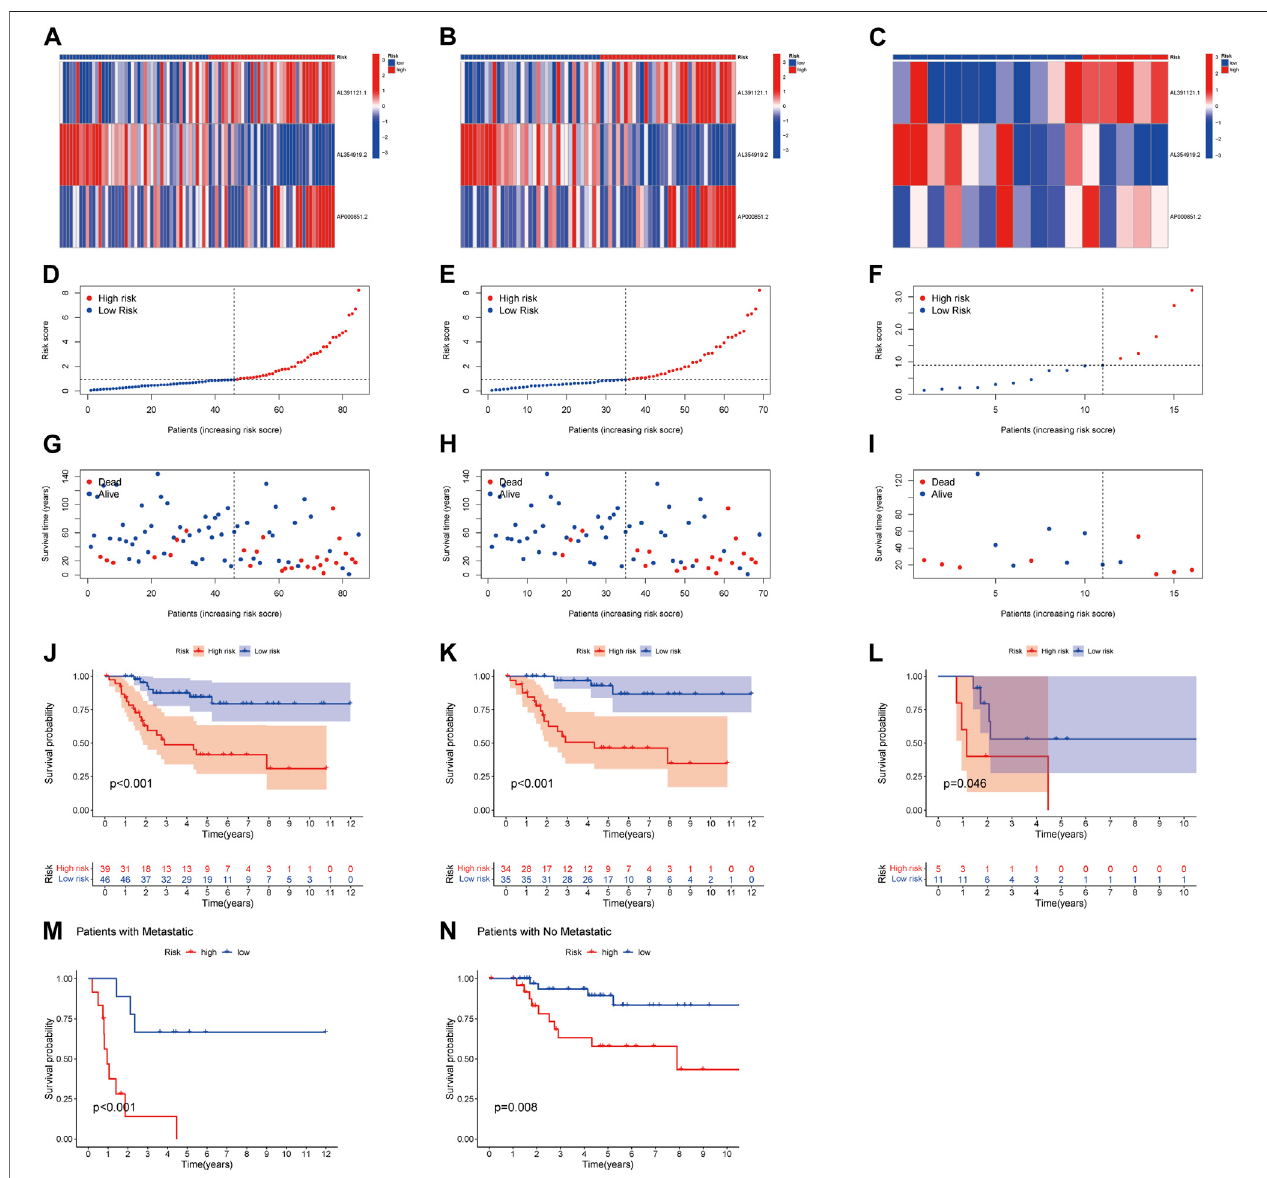
FIGURE3| Prognosisoftheriskmodelintheentire,training,andtestingsets. (A – C) HeatmapoftheexpressionofthreelncRNAsintheentire,training,andtesting sets, respectively. (D – F) Risk model of the entire, training, and testing sets, respectively. (G – I) Survival time and survival status in the entire, training, and testing sets, respectively. (J – L) Kaplan – Meier survival curves of patients with OS in the entire, training, and testing sets, respectively. (M – N) Kaplan – Meier survival curves of patients with tumor metastasis and tumor